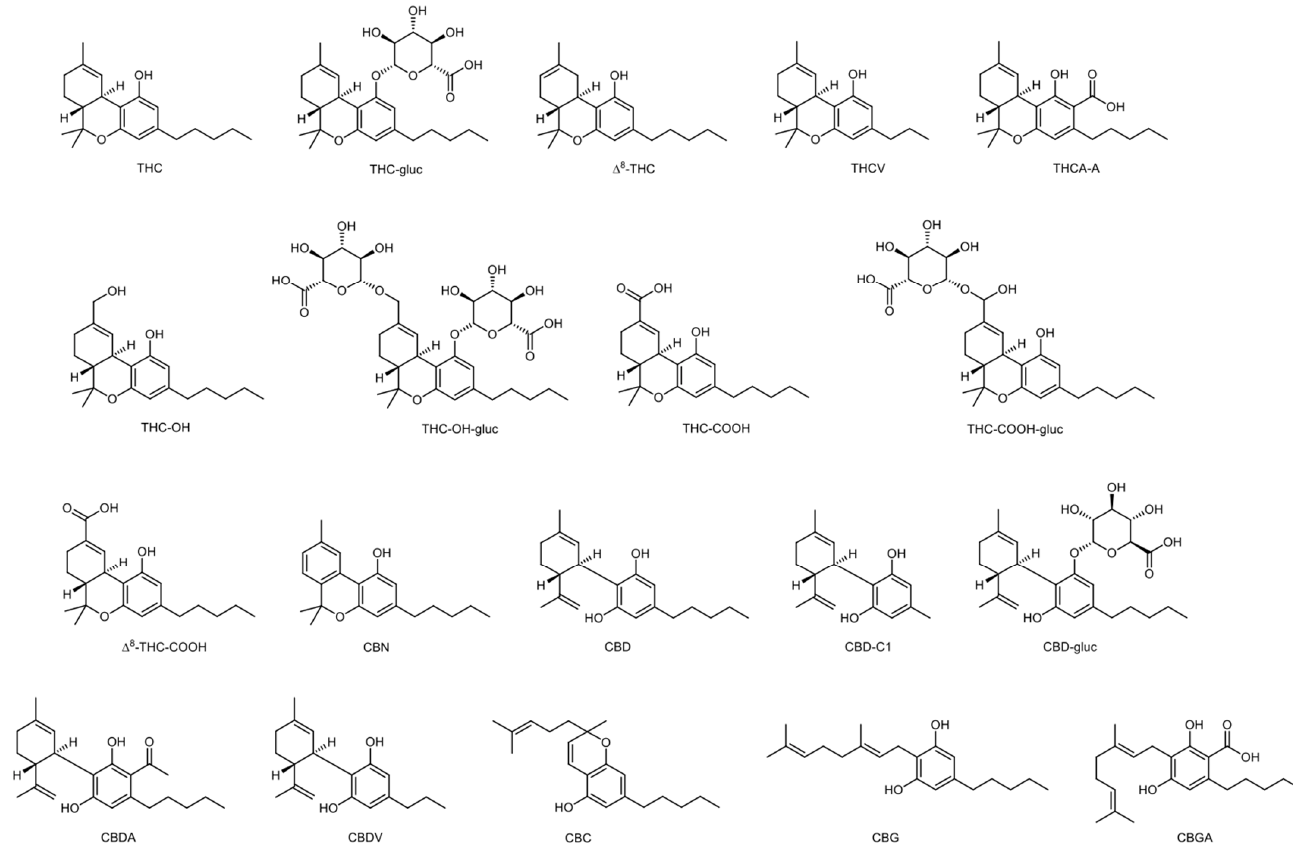
Figure 1. Naturally occurring cannabinoids and metabolites.